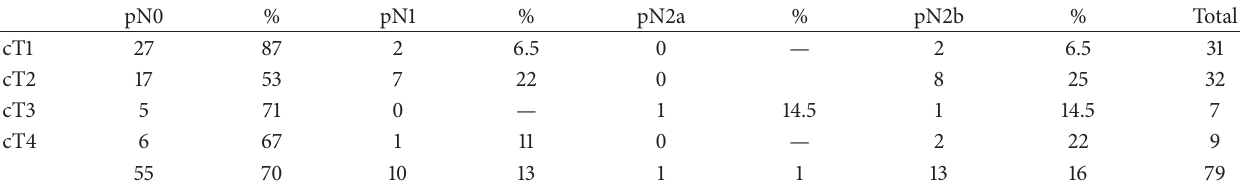
Table 7: Frequency of node positivity on histopathology in patients with well-differentiated tumors and clinically node negative